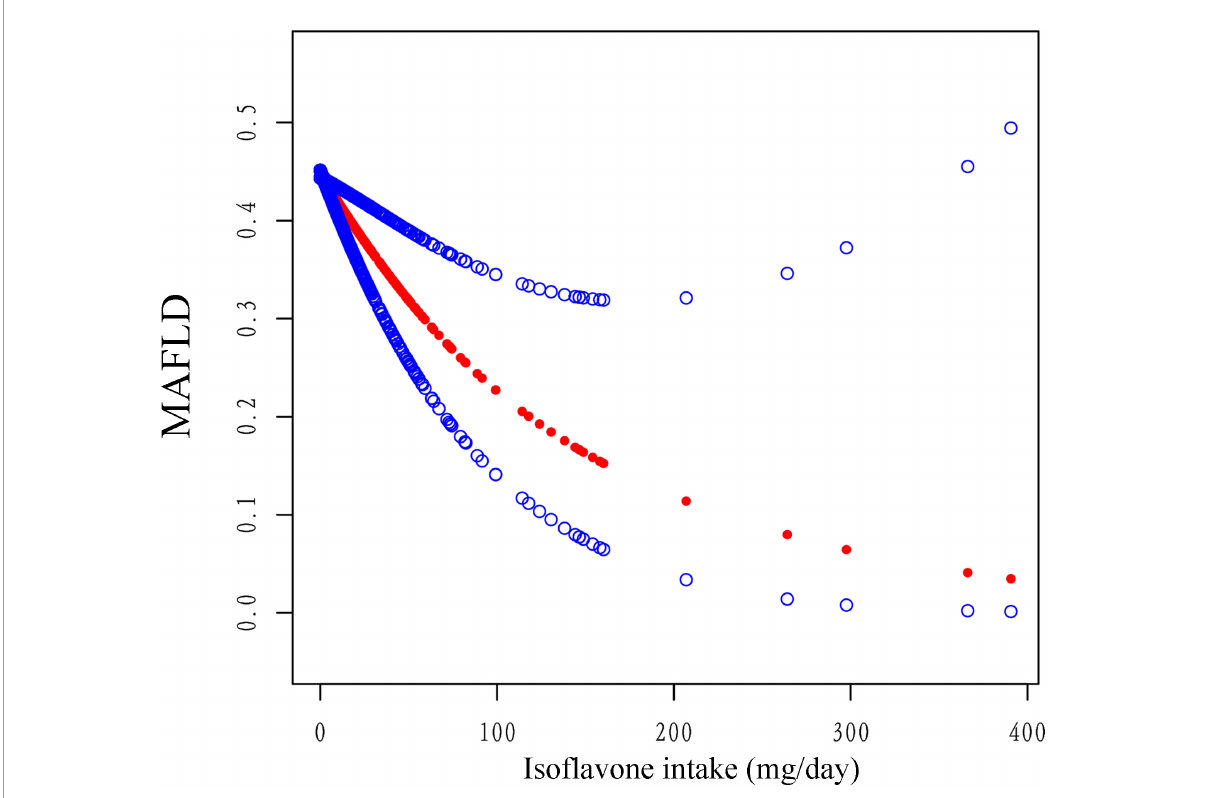
FIGURE3 The association between isoflavone intake and the risk of MAFLD using smooth curve fitting, weighted. Age, sex, race, PIR, smoking status, alcohol drinking status, education level, total energy and HEI-2015 scores were adjusted. The red points line represented the fitting spline. The blue points line represented the 95% confidence